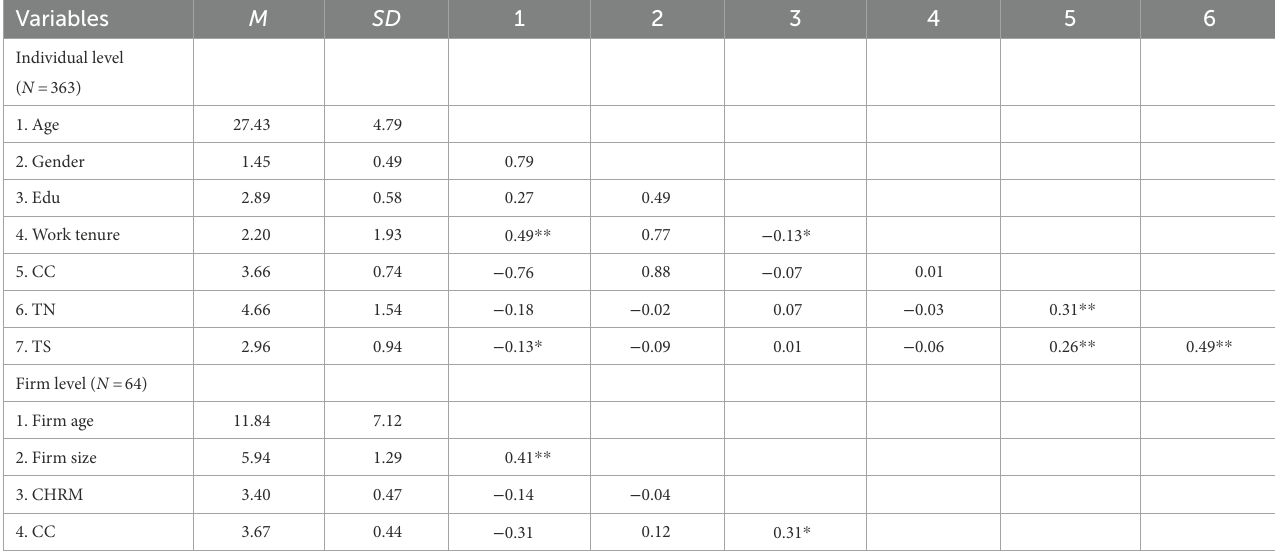
TABLE 4 Descriptive statistics, means, standard deviations, and correlations. Variables